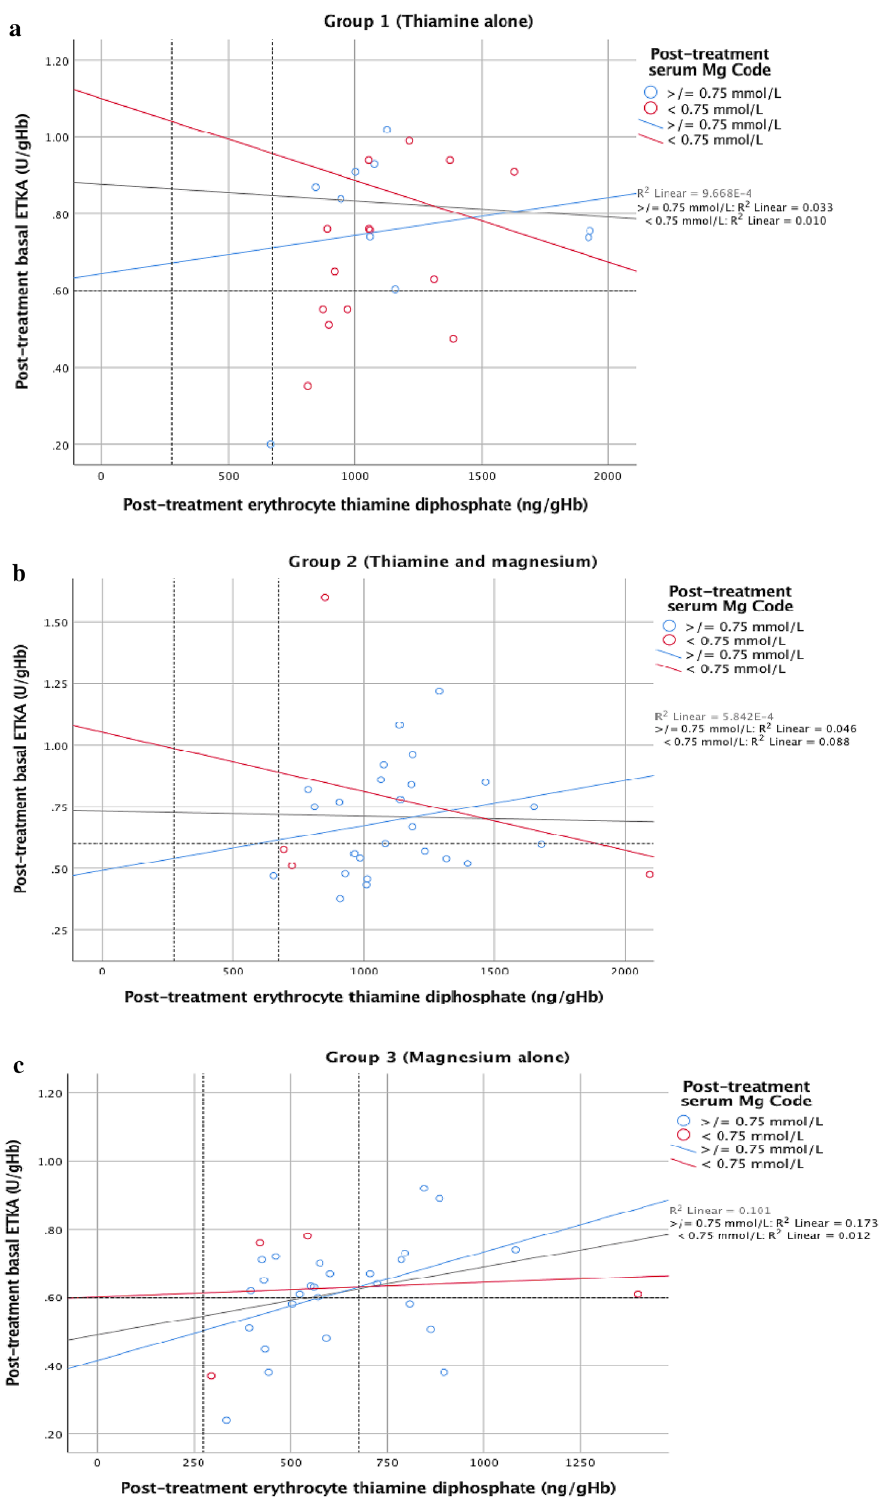
Figure 6. ( a ) Group 1 post-treatment basal ETKA versus erythrocyte TDP (n = 33), ( b ) Group 2 post-treatment basal ETKA versus erythrocyte TDP (n = 31), ( c ) Group 3 post-treatment basal ETKA versus erythrocyte TDP (n =